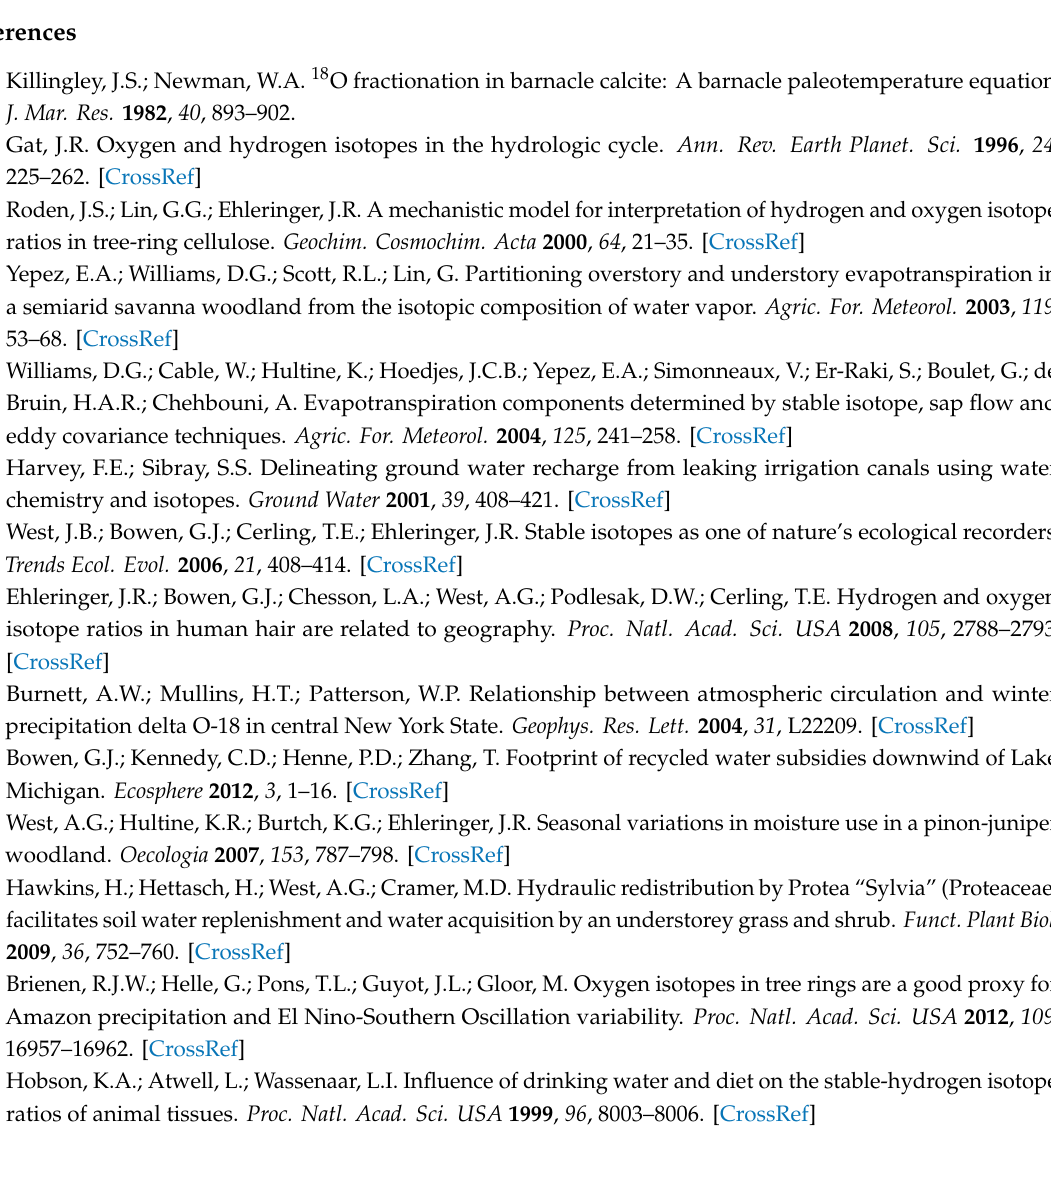
Figure S1. Relationship between δ 2 H and δ 18 O in collected precipitation and surface water in Lanzhou. 35 precipitation samples were gathered from 35 precipitation events at the site of Qiujiawan from April 2016 and October 2016. 24 surface water samples were monthly collected at the site of Zhongshan Bridge in the Yellow River located in Lanzhou between March 2016 and February 2018. (GMWL: Global Meteoric Water Line, LMWL: Local Meteoric Water Line, LSWL: Local Surface Water Line), Figure S2. Relationship between δ 2 H and δ 18 O in precipitation of Lanzhou from the Global Network of Isotopes in Precipitation (GNIP). The monthly mean values of δ 2 H and δ 18 O in precipitation at the site of Lanzhou from 1985 to 1999 were used, and the monthly mean values of δ 2 H and δ 18 O in February were absent. (GMWL: Global Meteoric Water Line, LMWL: Local Meteoric Water Line). Figure S3. Correlation coe ffi cients of stable isotope ratios in tap water with those in collected precipitation and surface water at all sampling sites. (a) correlation coe ffi cient ( R ) of δ 18 O, (b) correlation coe ffi cient ( R ) of δ 2